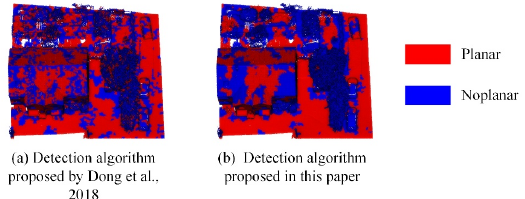
Figure 3 . Comparison of the planar region detection